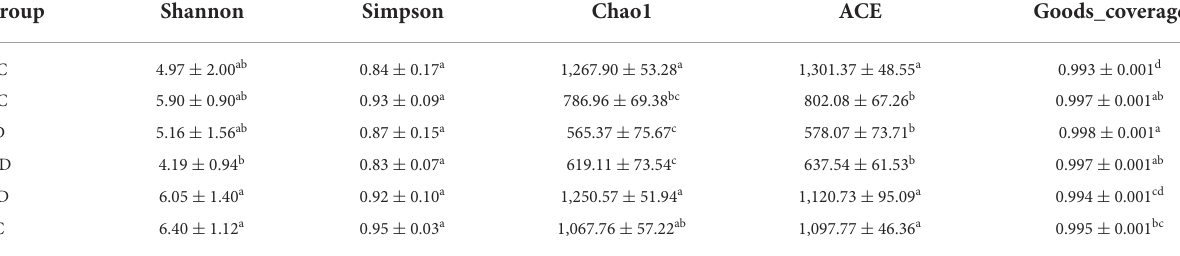
TABLE 3 Alpha diversity analysis of the gut